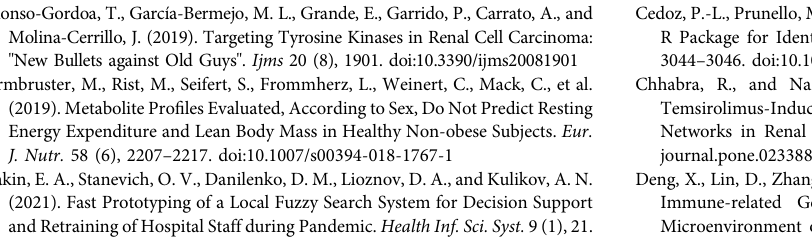
Supplementary Figure 1 | Heatmap of 106 DEGs in normal samples and RCC samples. Heatmap of 106 DEG expressions in normal samples and RCC samples. Supplementary Figure 2 | Functional enrichment analysis of 106 DEGs. (A, B) GO enrichment analysis of 106 DEGs. GO term enrichment in cellular component (A) and molecular function (B) . Supplementary Figure 3 | Survival analysis on eight DEMDGs based on TCGA dataset. K – M survival analysis of eight DEMDGs in TCGA whole cohort (K – M, Kaplan – Meier). Supplementary Figure 4 | Correlation analysis between the expression levels of eight DEMDGs and the corresponding methylation levels of each gene. (A – H) Relation of expression levels and methylation levels of the eight DEMDGs and the corresponding distribution map of the methylation degrees: (A) LCP2, (B)